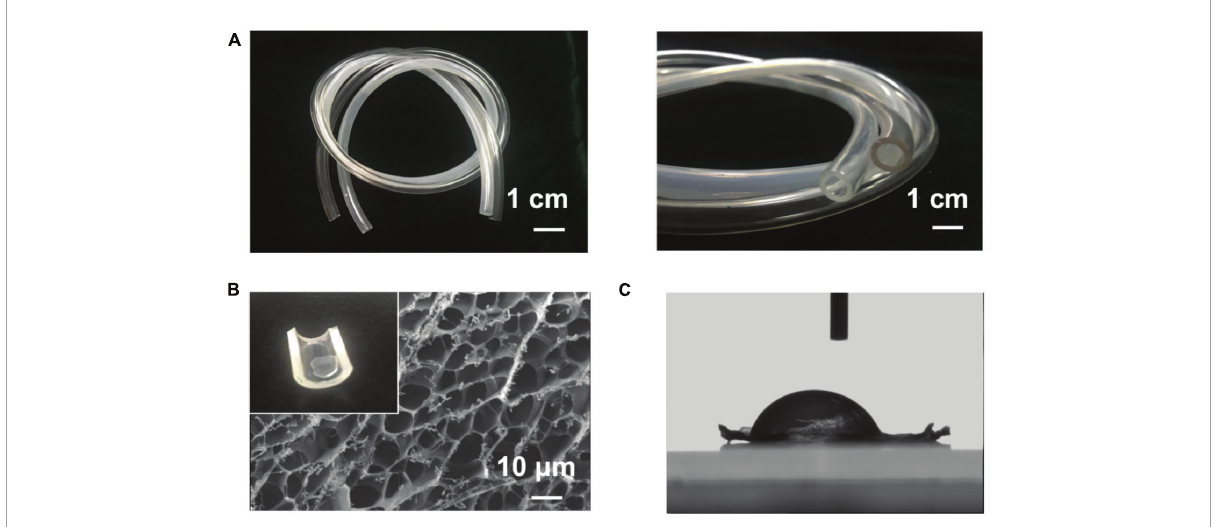
FIGURE2 The image of methacrylated alginate (MA-SA)-hydrogel coatings on polyvinyl chloride (PVC) surfaces. (A) Macro images of the coating and the pristine tubing demonstrate that the method used here can produce a transparent and uniform hydrogel coating. (B) The scanning electron microscope (SEM) image of the methacrylated alginate (MA-SA)-hydrogel and the inset in the upper left corner of the hydrogel drop on the surface of the PVC tube. (C) The contact angle of